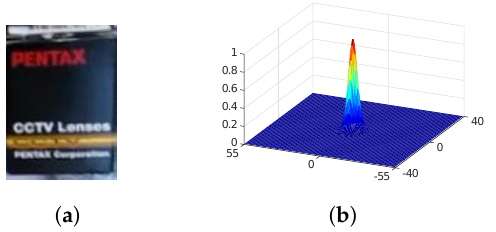
Figure 7. Reference image p and output q . ( a ) Reference p ; ( b ) Output q of model of two-dimensional peak-centered Gaussian-like